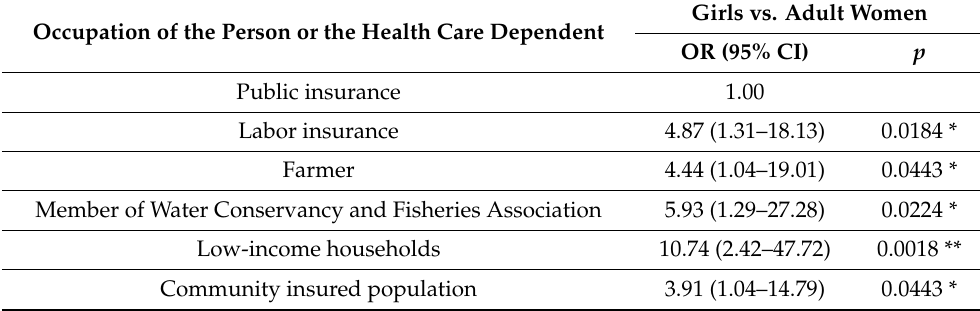
Table 5. Relative risk for victims of sexual assault (by